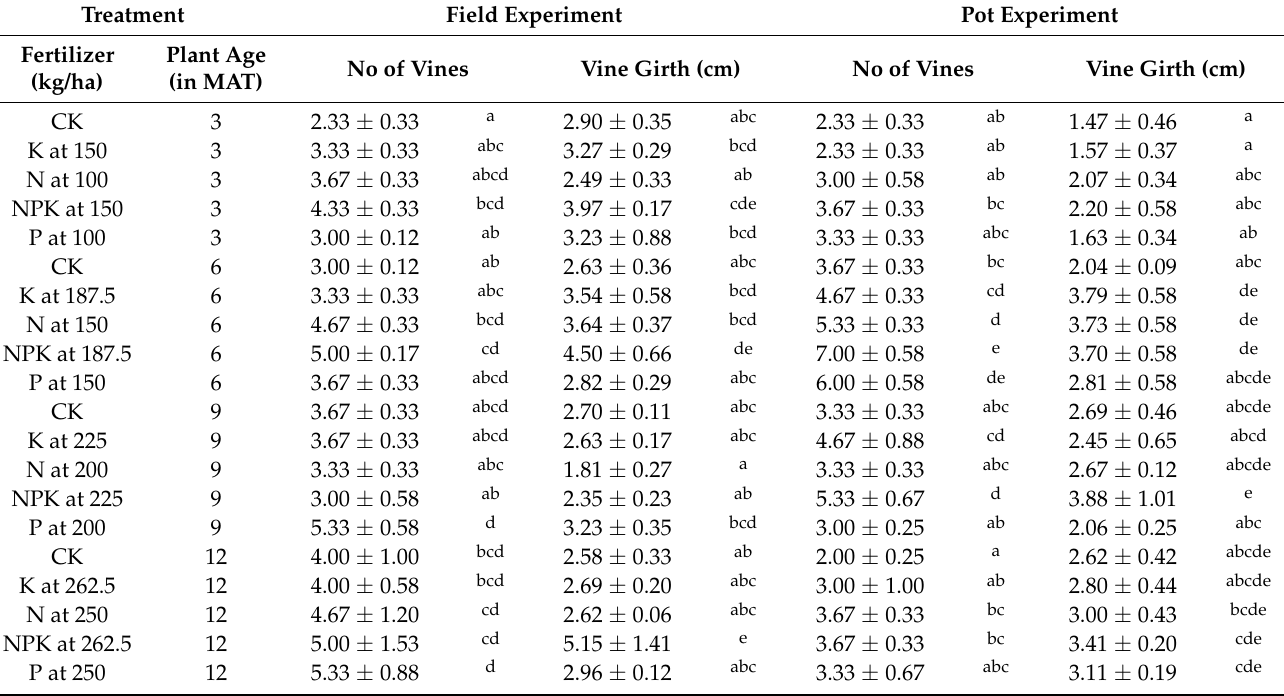
Table 1. Effects of inorganic fertilizers on vine number and girth of C. sanguinolenta at different plant growth